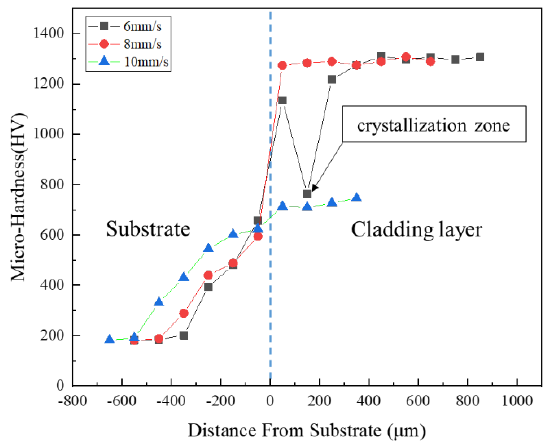
Figure 8. Variation of microhardness in the thickness direction of laser claddings produced with different scanning speeds.